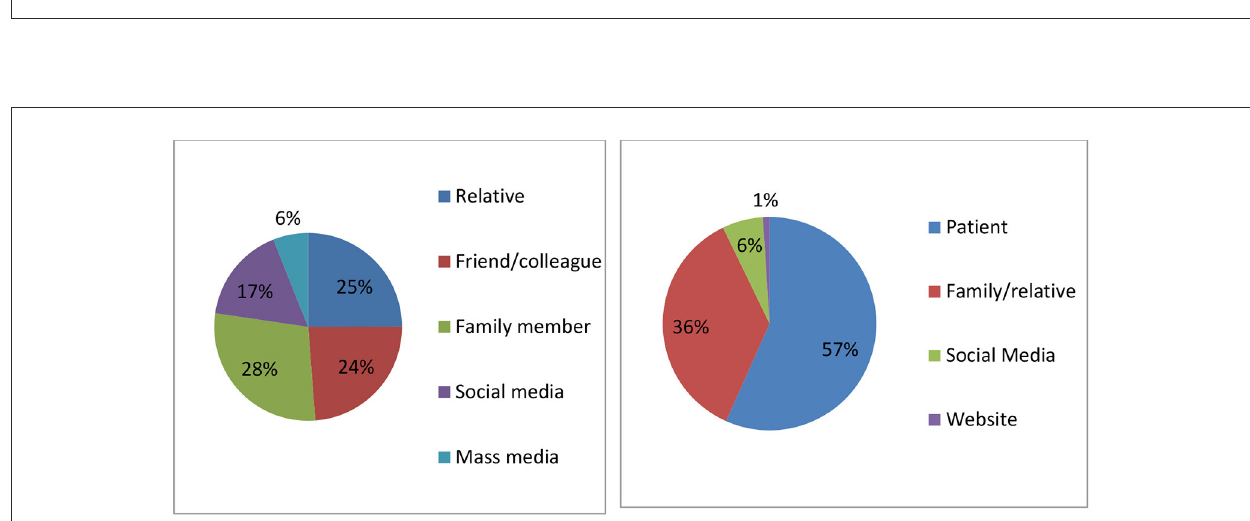
FIGURE2 Distribution of the study participants’ key source of information of medical tourism in India (left) and influential source for decision-making (right) .